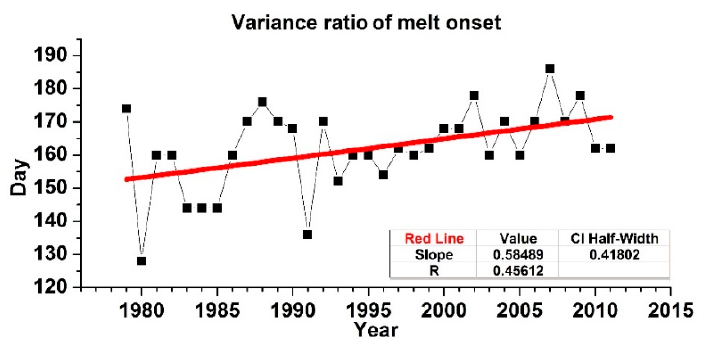
Figure 1. Rate of change of the Antarctic melt onset date.